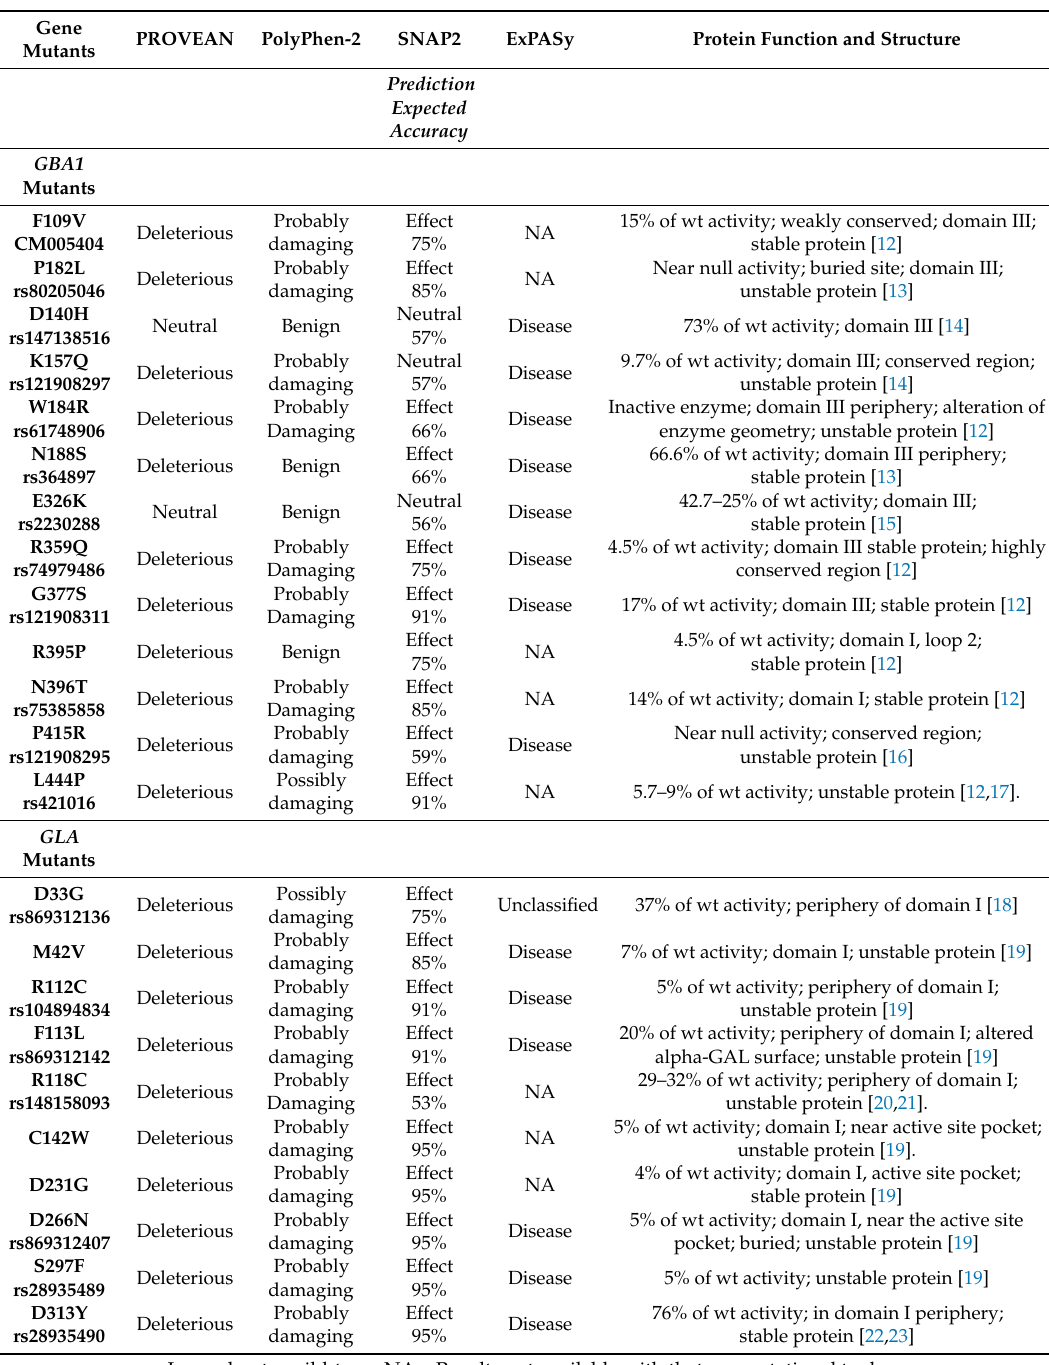
Table 1. In silico analysis comparison of 23 missense mutations in the GBA1 and GLA genes. Gene PROVEAN PolyPhen-2 SNAP2 ExPASy Protein Function and Mutants